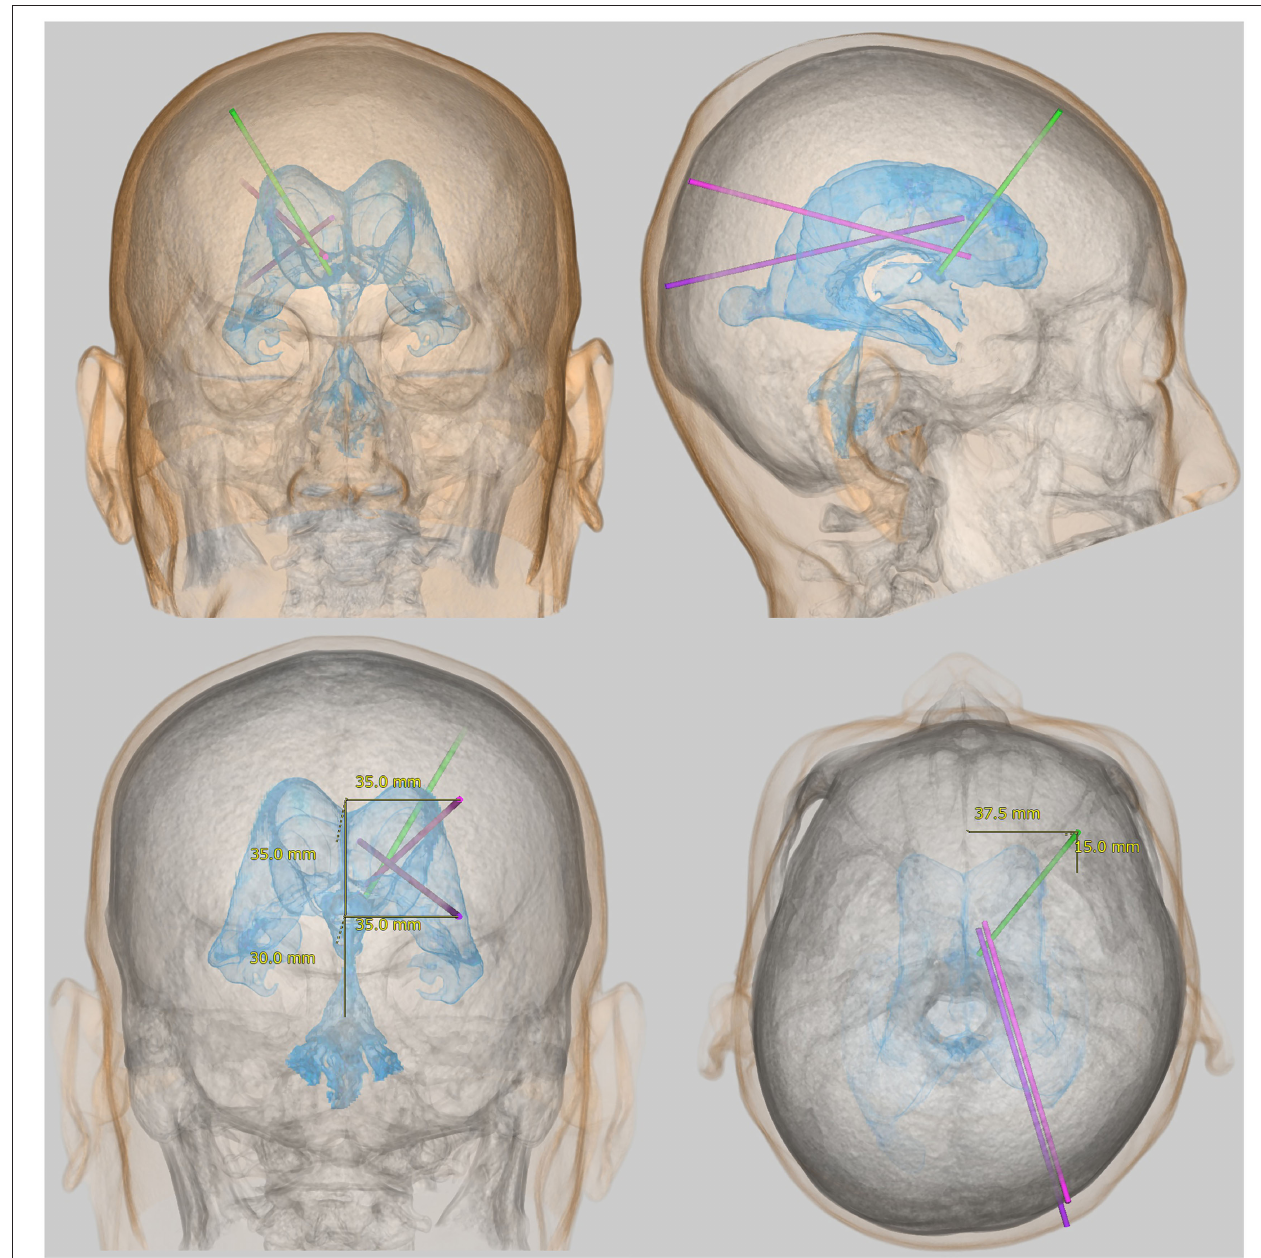
FIGURE 1 | Representative approaches for placement of a ventricular catheter in the lateral ventricle. The light green bar indicates the root for the frontal approach from the coronal point, the purple bar indicates the root for the occipital approach from Dandy’s point, and the pink bar indicates the root for the parietooccipital approach from Frazier’s